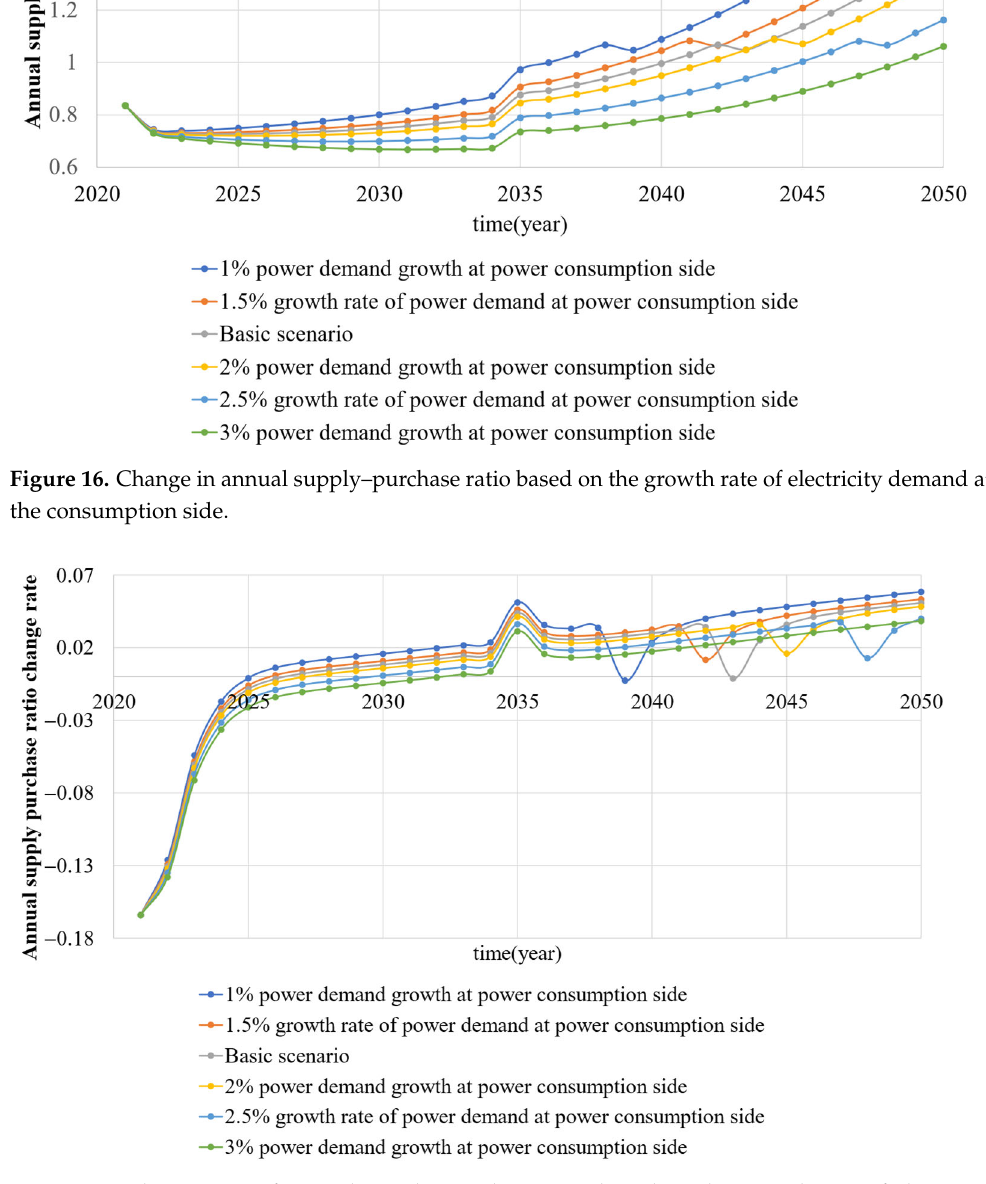
Figure 17. Change rate of annual supply–purchase ratio based on the growth rate of electricity demand at the consumption side.